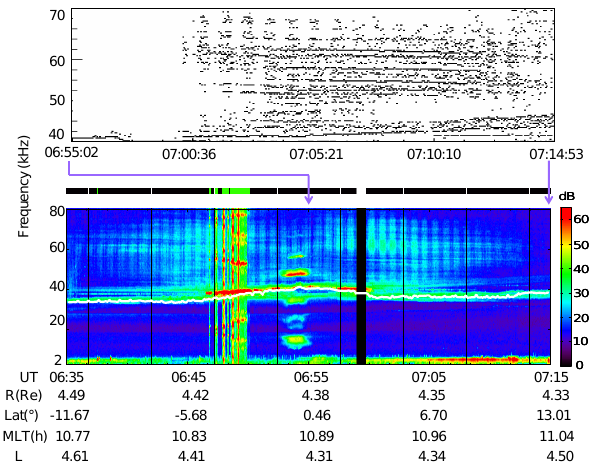
Fig. 1. Spectrograms of natural emissions observed on 26 Septem- ber 2003 by the WHISPER instrument on board C3 satellite. Top: Frequency/time positions of intensity maxima in the 40–80kHz band. The lower maxima were suppressed (see text). Bottom: Frequency/time spectrogram in the 2–80kHz frequency band. The white line indicates the position of local plasma frequency, and the bar above the spectrogram shows the status of each spectrum (white: data gap; black: clean spectrum; green: saturated